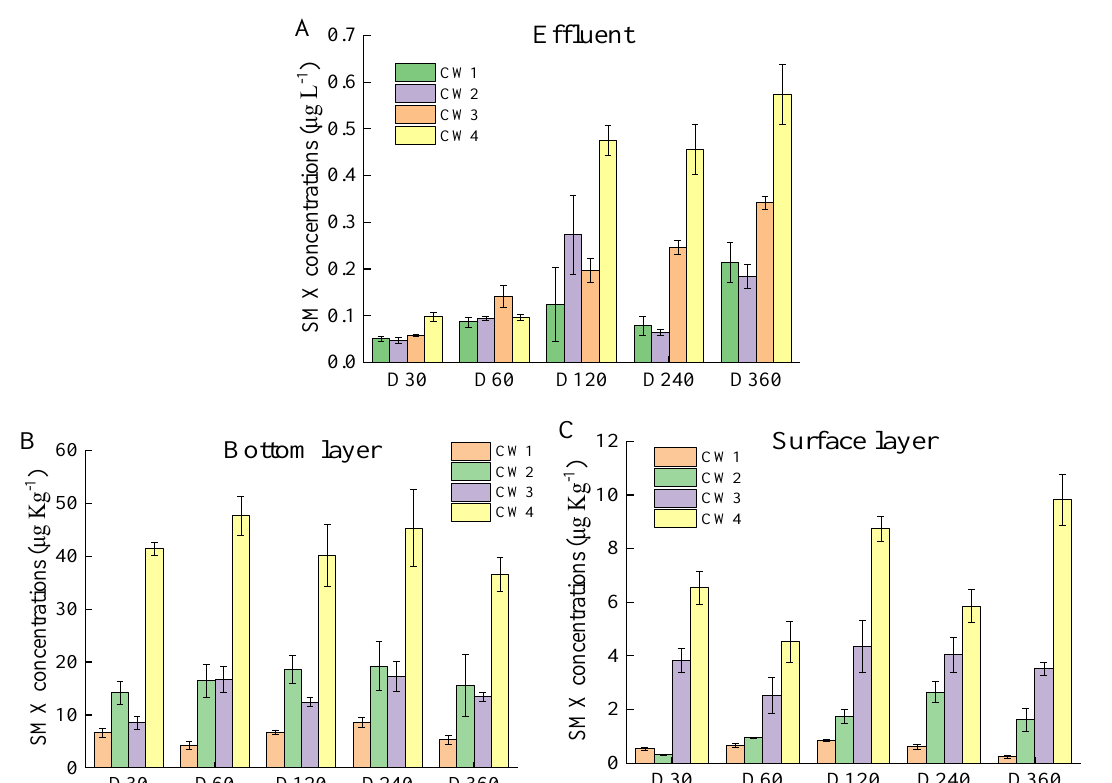
Figure 1. Concentrations of SMX (mean ± SD, n = 3) in the effluent water and layers. ( A ) concentration of SMX in the effluent; ( B ) concentration of SMX in the bottom layer; ( C ) concentration of SMX in the surface layer.